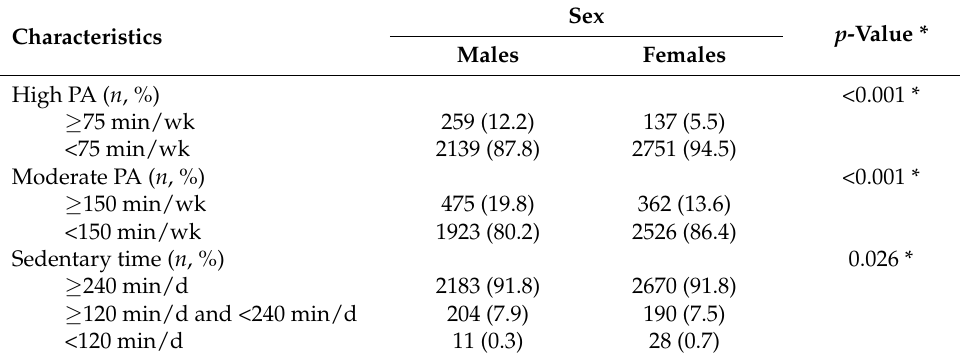
Table 6. General characteristics of